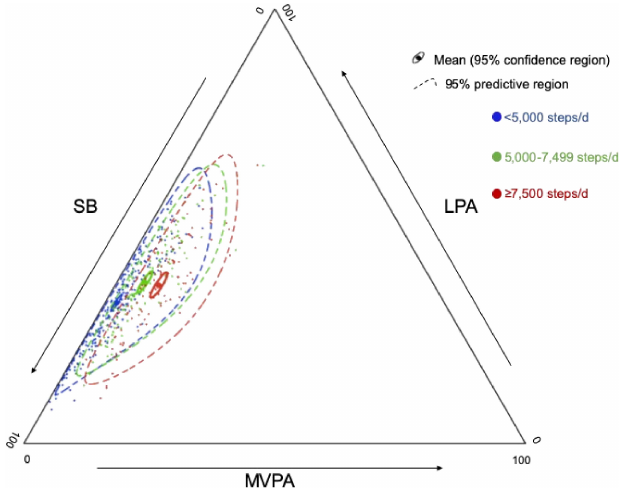
Figure 1. Ternary diagrams of the compositions of time spent in intensities of physical activity and sedentary behaviors by step-based categories. LPA, light- vigorous physical activity; SB, sedentary behavior. Table 2. Variation matrix of time spent in sedentary,